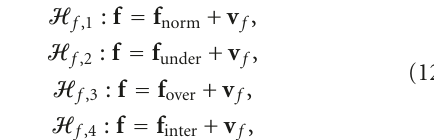
Figure 4: Novel paradigm for the classification of single and multi- ple